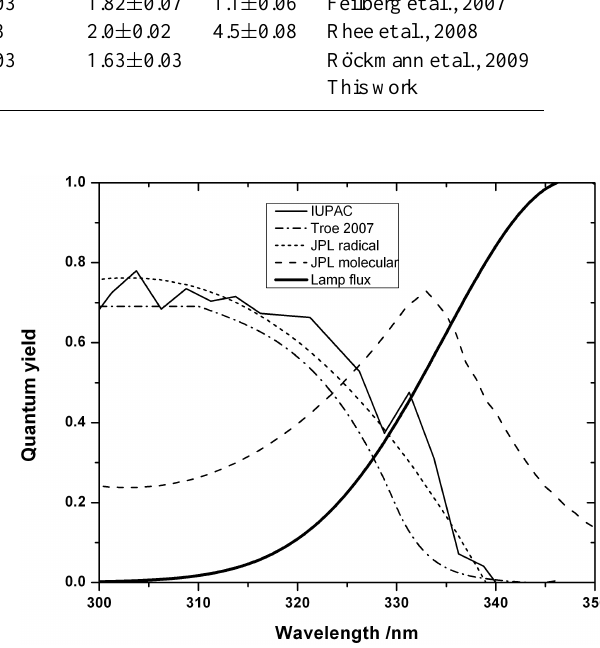
Fig. 1. Pressure independent quantum yields of radical products of formaldehyde photolysis as a function of wavelength from JPL (Sander et al., 2006), IUPAC (Atkinson et al., 2005), and the lowest estimate by Troe (Troe, 2007). The JPL quantum yield in the molec- ular channel, for a pressure of 1atm, is included for comparison. Thicker full drawn line is the emission spectrum of the UV-A lamp (Osram Eversun 100W/79) used for the photolysis